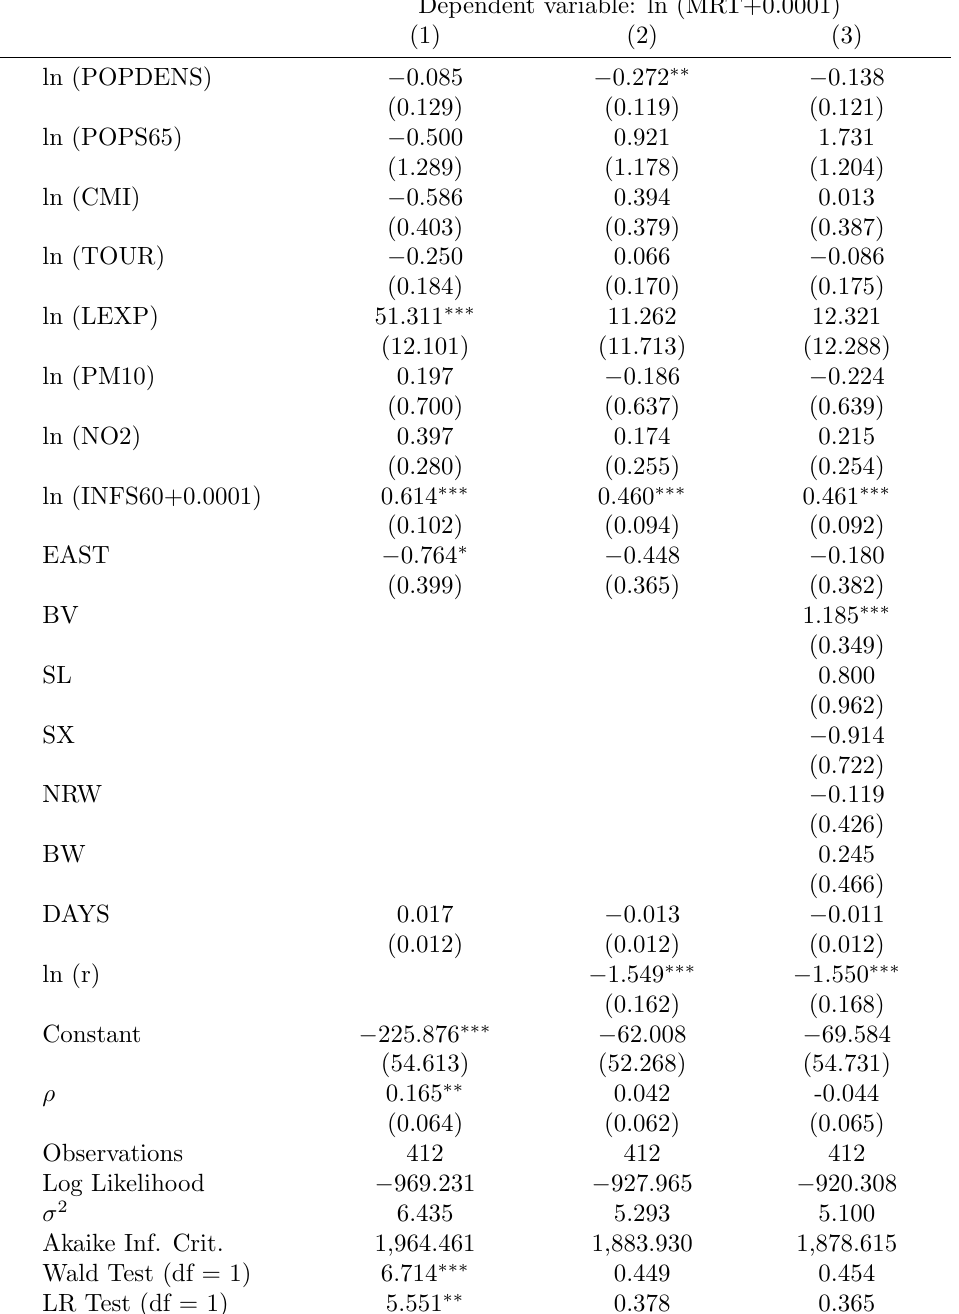
Table 11: Estimation results for the mortality model (spatial lag